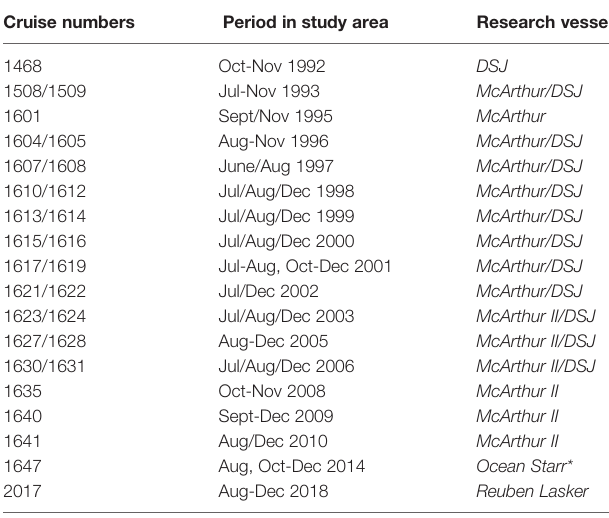
TABLE 1 | Cetacean and ecosystem assessment surveys conducted within the Southern California Current study area during 1992 –